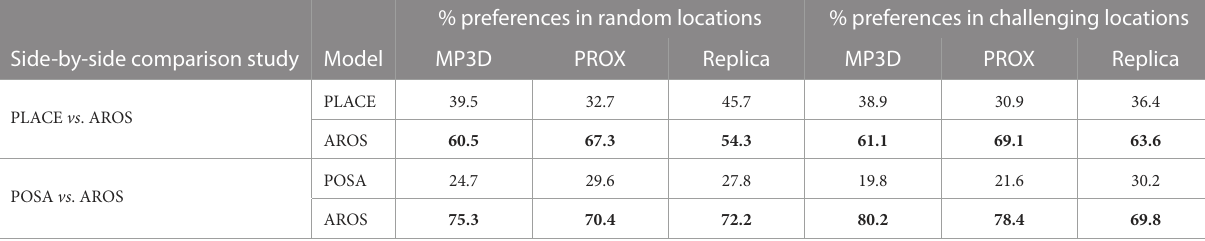
TABLE4 MTurkside-by-sidestudiesresultsinrandomandchallenginglocations.Thebestareinboldface. % preferences in random locations % preferences in challenging locations Side-by-side comparison study